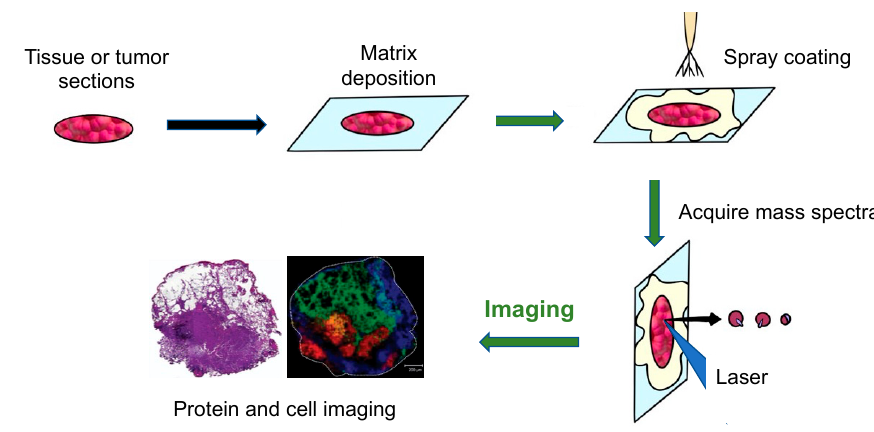
Figure 3. The principal workflow of the MALDI imaging and profiling experiments [24].